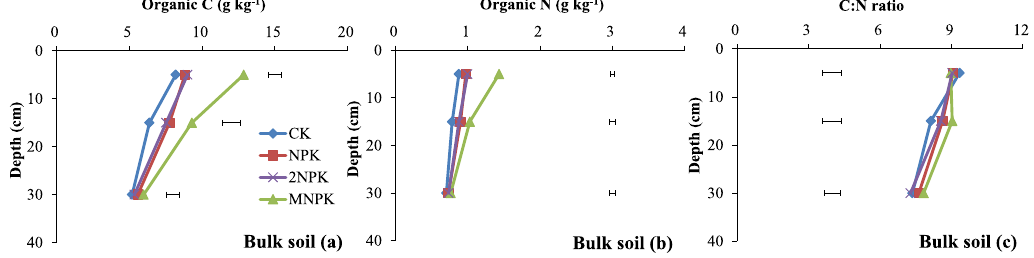
Figure 1. Organic C and N concentrations and C/N ratios in bulk soil and water-stable aggregate fractions to 40 cm deep in the control treatment (CK), chemical fertilizer treatments (NPK and 2NPK), and combined manure and chemical fertilizer treatment (MNPK). Each value is the mean of three replicates. The horizontal lines indicate the least significant difference values at the 0.05 level (LSD0.05) for the different treatments at the different depths. The abbreviations for aggregates of each size are shown in the footnote to Table